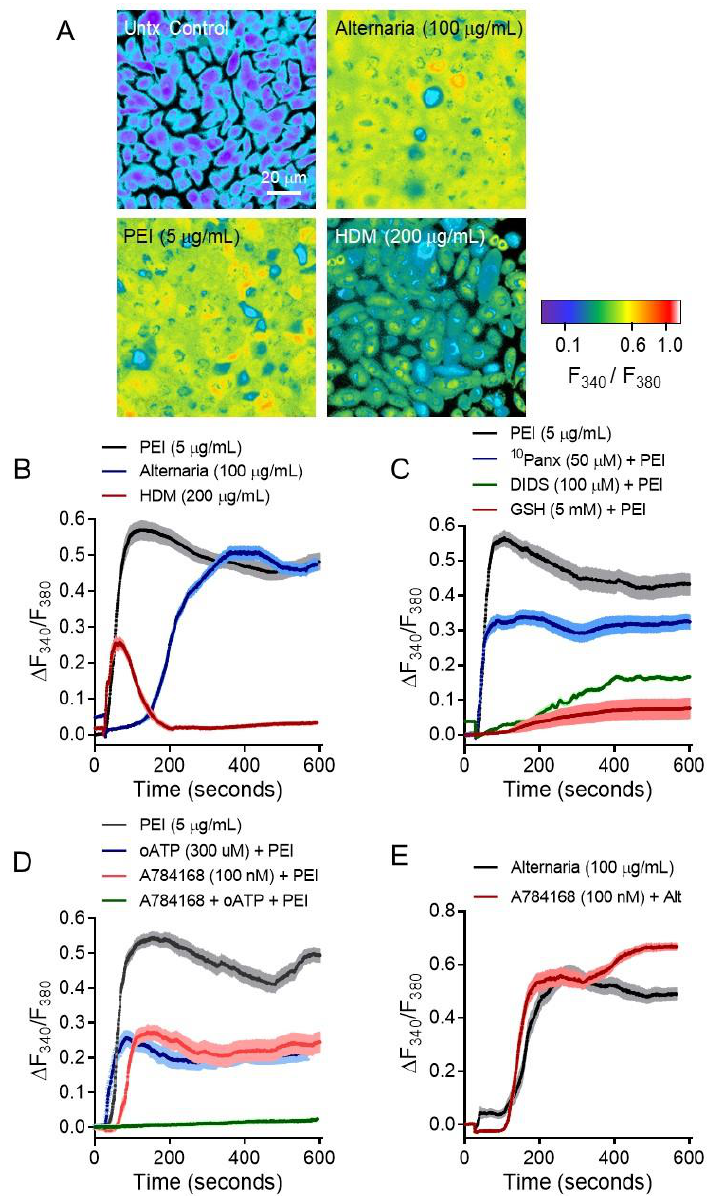
Figure 2. Allergen and PEI induced increases in [Ca 2+ ] i . ( A ). Pseudo-color images of hBE cells loaded with the ratiometric Ca 2+ indicator, Fura-2. The resting level of intracellular [Ca 2+ ] is shown in the untreated (Untx) control image. After exposure to PEI (5 μg /mL) or Alternaria (100 μg /mL), the increase in [Ca 2+ ] is indicated by a change in color from blue to yellow/orange. In cells treated with 200 μg /mL HDM, the peak Ca 2+ response was less than observed with PEI or Alternaria. ( B ). Comparison of the kinetics of PEI (5 μg /mL; n = 36), Alternaria (100 μg /mL; n = 36) and HDM (200 μg /mL; n = 36) — evoked Ca 2+ responses. ( C ). Inhibitors of pannexin 1 ( 10 Panx, 50 μ M; n = 36), VDAC-1 (DIDS, 100 μM: n = 36) and oxidative stress (GSH, 5 mM; n = 36), which block ATP release also reduced PEI (5 μg /mL)-induced increases in [Ca 2+ ] i . ( D ). The selective TRPV1 antagonist (A784168, 100 nM, n = 36) and the P2X- receptor antagonist (oATP, 300 μM; n = 36) inhibited ~50% of the PEI-induced Ca 2+ response. When hBE cells were pretreated with both antagonists, the PEI-stimulated Ca 2+ response was completely blocked. ( E ). In contrast, the TRPV1 antagonist A784168 (100 nM; n = 36) does not inhibit Alternaria-evoked increases in [Ca 2+ ] i .